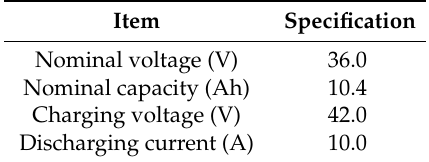
Figure 6. Experiment setup of the 36V electric bicycle: ( a ) 36V electric bicycle with the experimental equipment; ( b ) Schematic diagram of the numerical set-up of the 36V electric bicycle ECU. Table 4. Specifications of the Li-ion battery.